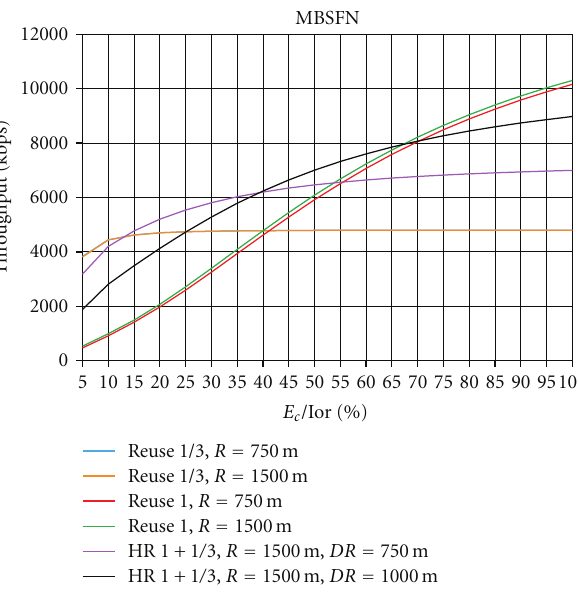
Figure 16: Throughput versus E c /Ior for SC-PTM (2RL) scenario. Figure 17: Throughput versus E c /Ior for MBSFN scenario.